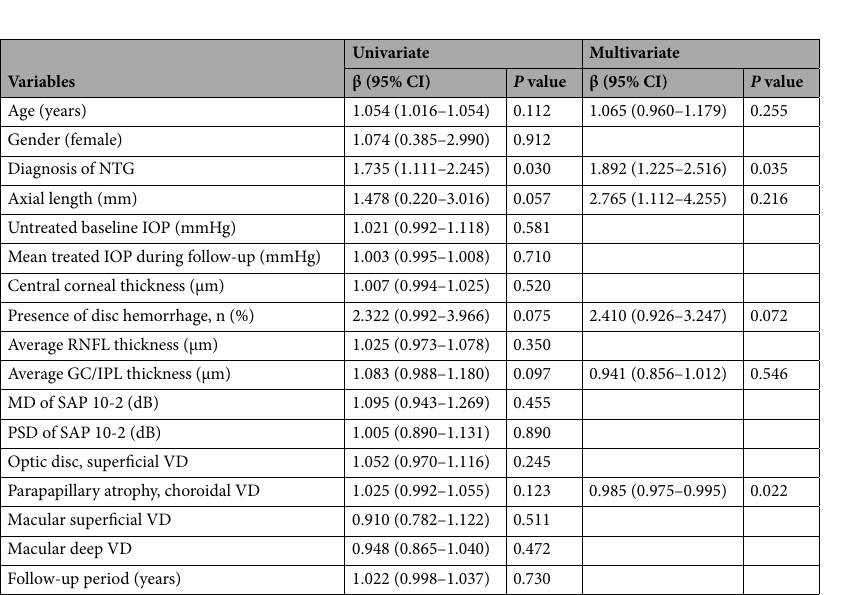
Table 4. Associated risk factors to innermost 10-2 VF progression in glaucoma patients. Variables with P < 0.2 were entered in the multivariate analysis. NTG, normal-tension glaucoma; IOP, intraocular pressure; RNFL, retinal nerve fiber layer; GC/IPL, ganglion cell/inner plexiform layer; MD, mean deviation; PSD, pattern standard deviation; VD, vessel